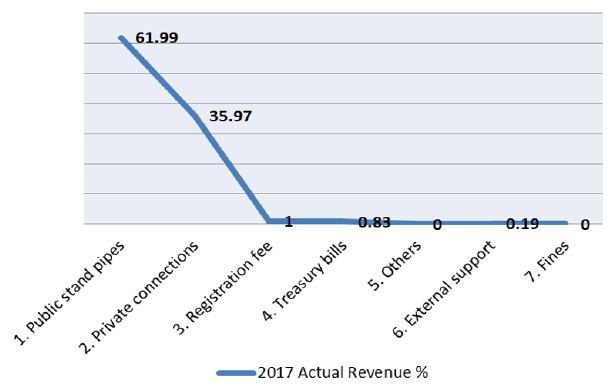
Figure 2. Revenue head for 2017.